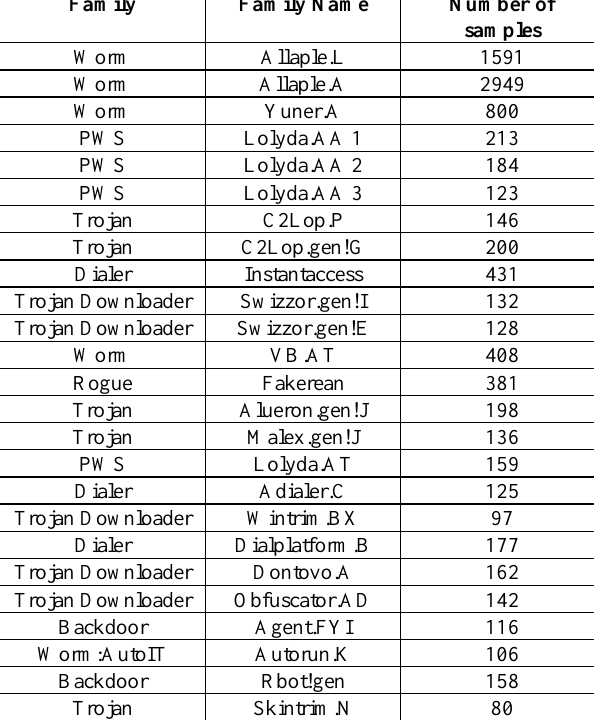
Table 1. MalImg: Distribution of Samples